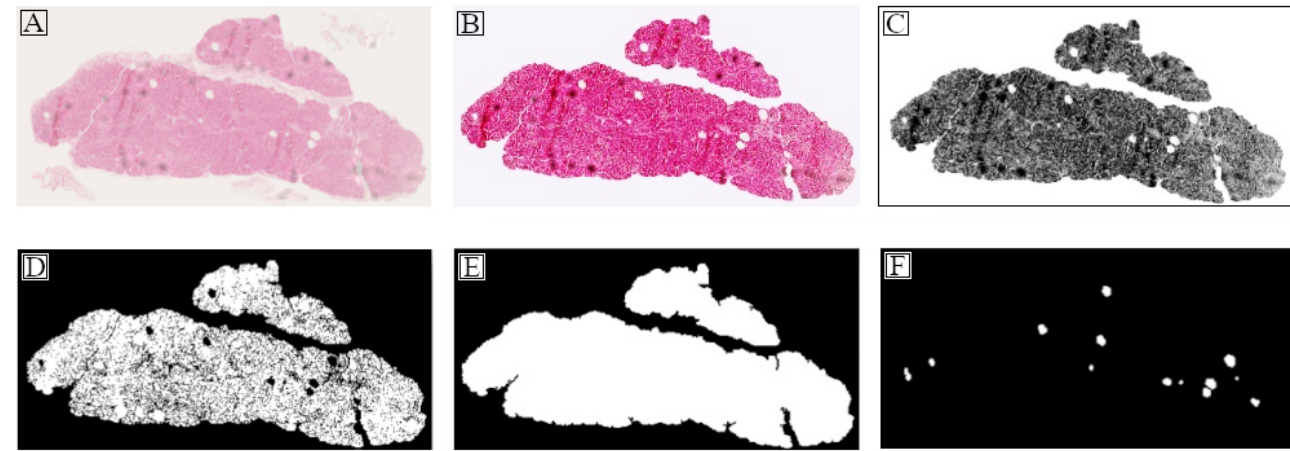
Figure 2. Visualization of image processing steps for the tissue region extraction and candidate fat droplets segmentation on the digitized biopsy specimens: ( A ) initial RGB biopsy image; ( B ) RGB color histogram equalization for contrast enhancement; ( C ) color image to grayscale conversion with pixel saturation; ( D ) grayscale image to binary conversion via adaptive thresholding; ( E ) binary tissue region identification; ( F ) morphological opening of circular white